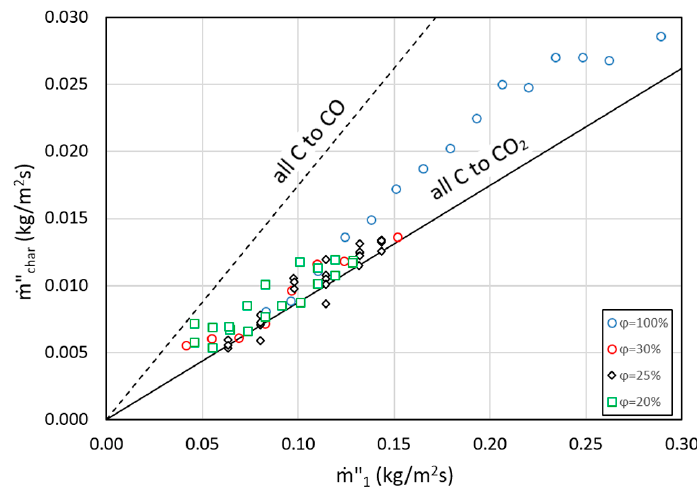
Figure 10. Comparison of the char burning rates with and without air staging ( φ ).